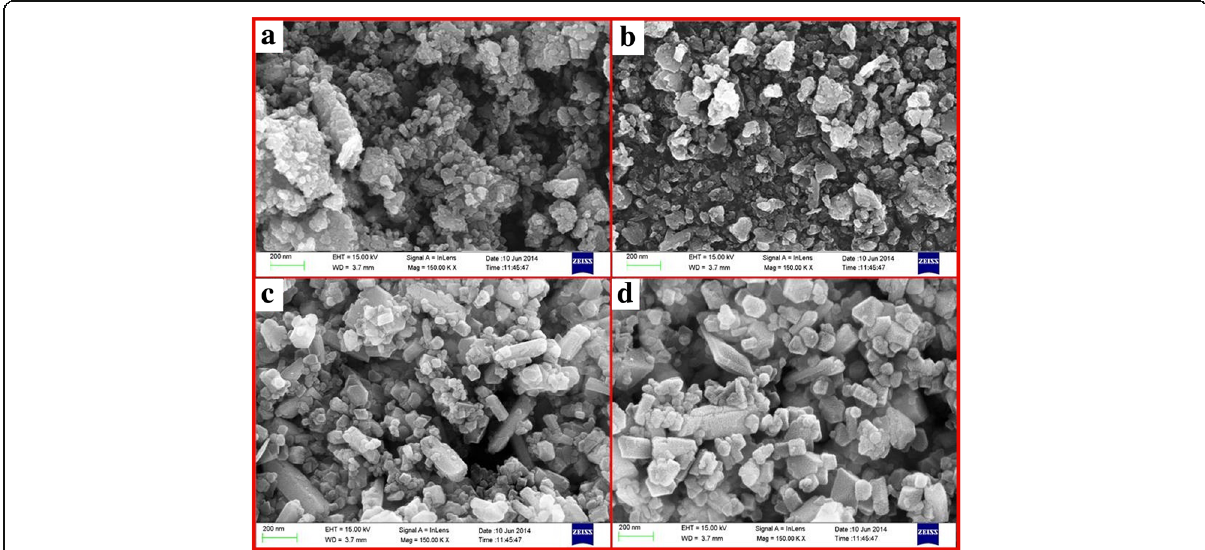
Fig. 3 FESEM photographs of pure and Mg-doped ZnO NPs. a Pure ZnO NPs. b 2.5% Mg-ZnO NPs. c 5% Mg-ZnO NPs. d 7.5% Mg- ZnO NPs